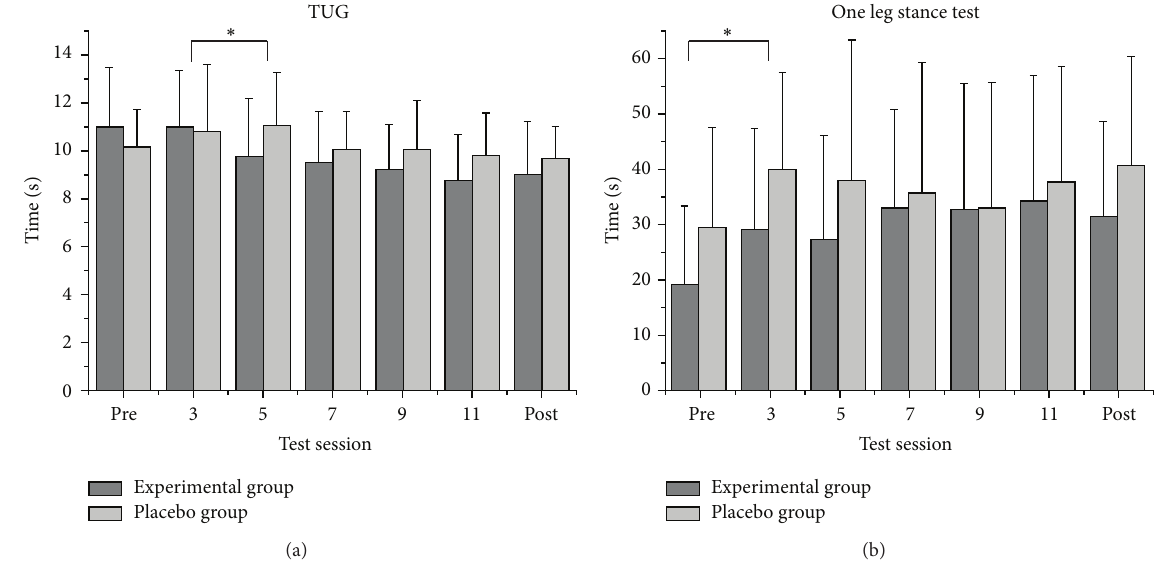
Figure 3: Results of the intrasession evaluation in the “Timed up and go test” (TUG (a)) and the “one leg stance test” (b). TUG: significant interaction “time ∗ group”; one leg stance: significant main effect of factor “time” ( ∗ 𝑃 < 0.05